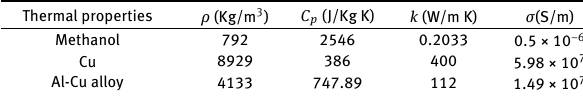
Table 1: Thermal properties for regular fluid and solidparticles Thermalproperties